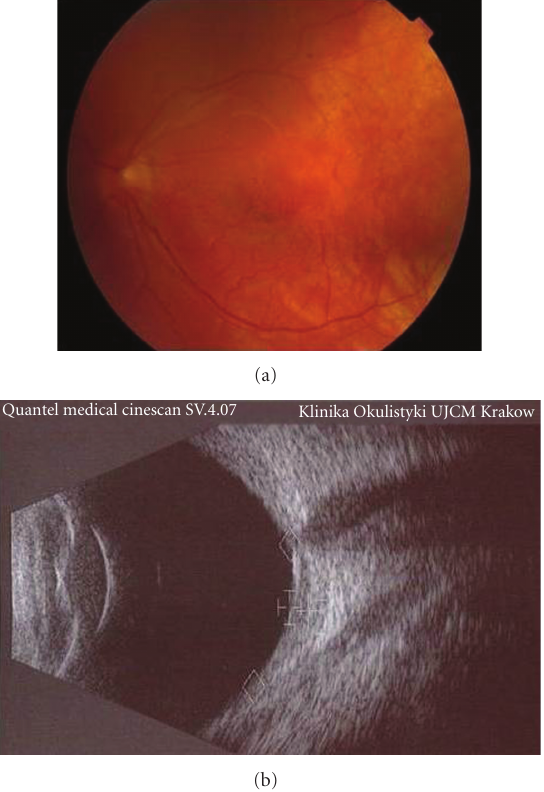
Figure 3: The same eye 18 months after Ruthenium-106 plaque therapy—regression of the tumor, no subretinal fluid is